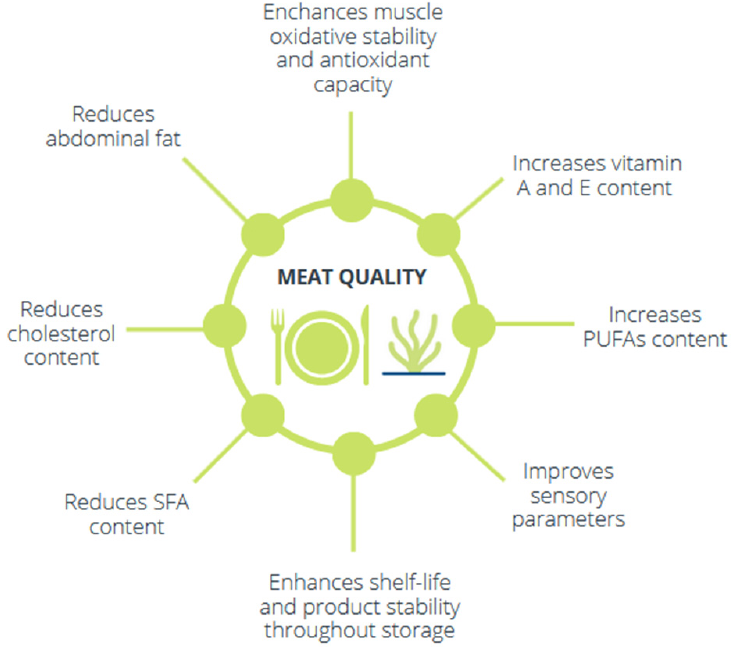
Figure 3. Benefits of seaweeds on meat quality.